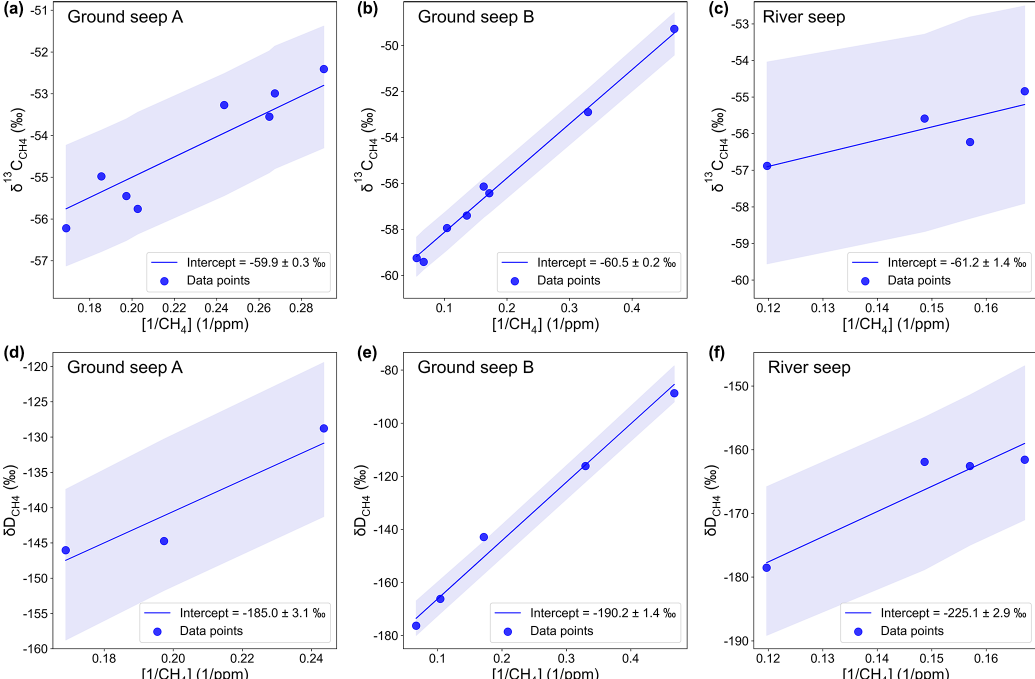
Figure A4. Keeling plots of all data from ground and river seeps analysed using Bayesian linear regression. Upper panels show the results for δ 13 C and lower panels show the results for δ D.